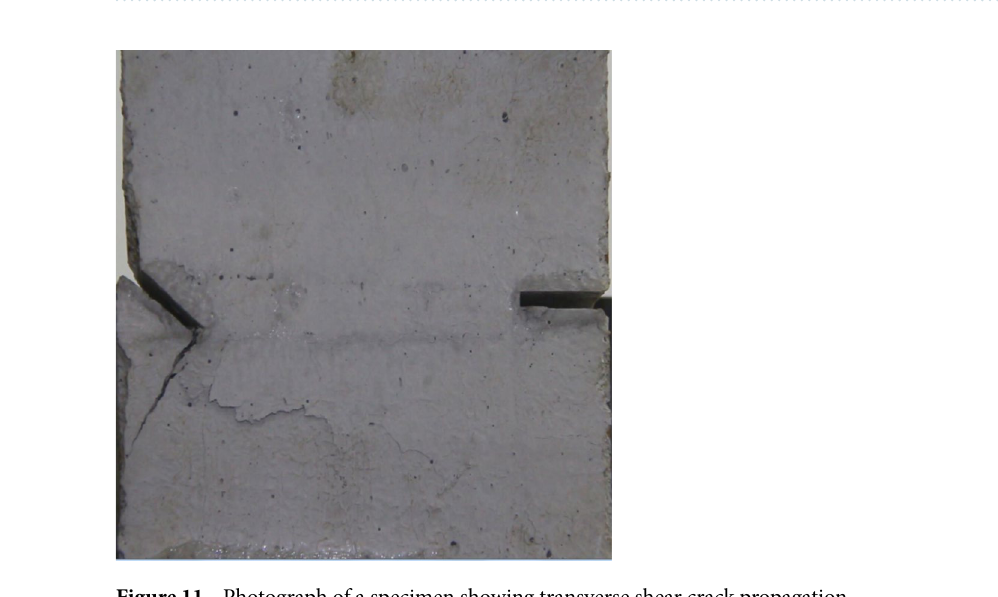
Figure 11. Photograph of a specimen showing transverse shear crack